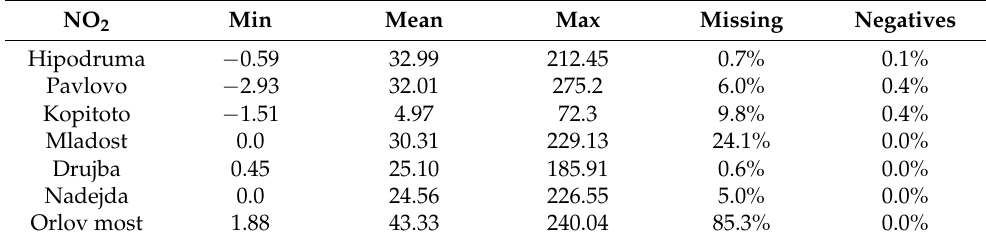
Table 2. Quality of the raw dataset for NO 2 .